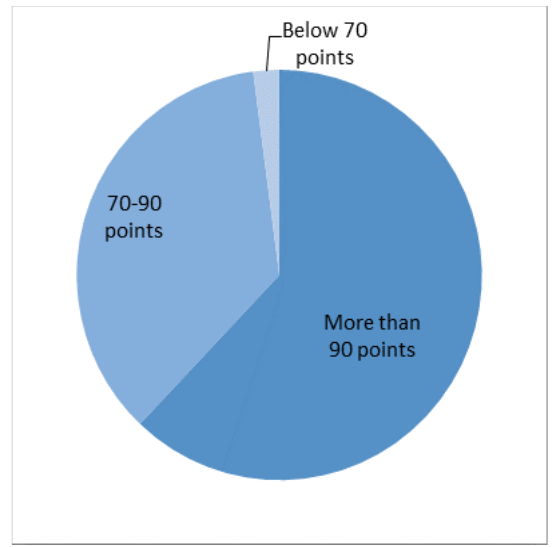
Figure 1. Distribution of collection accuracy score